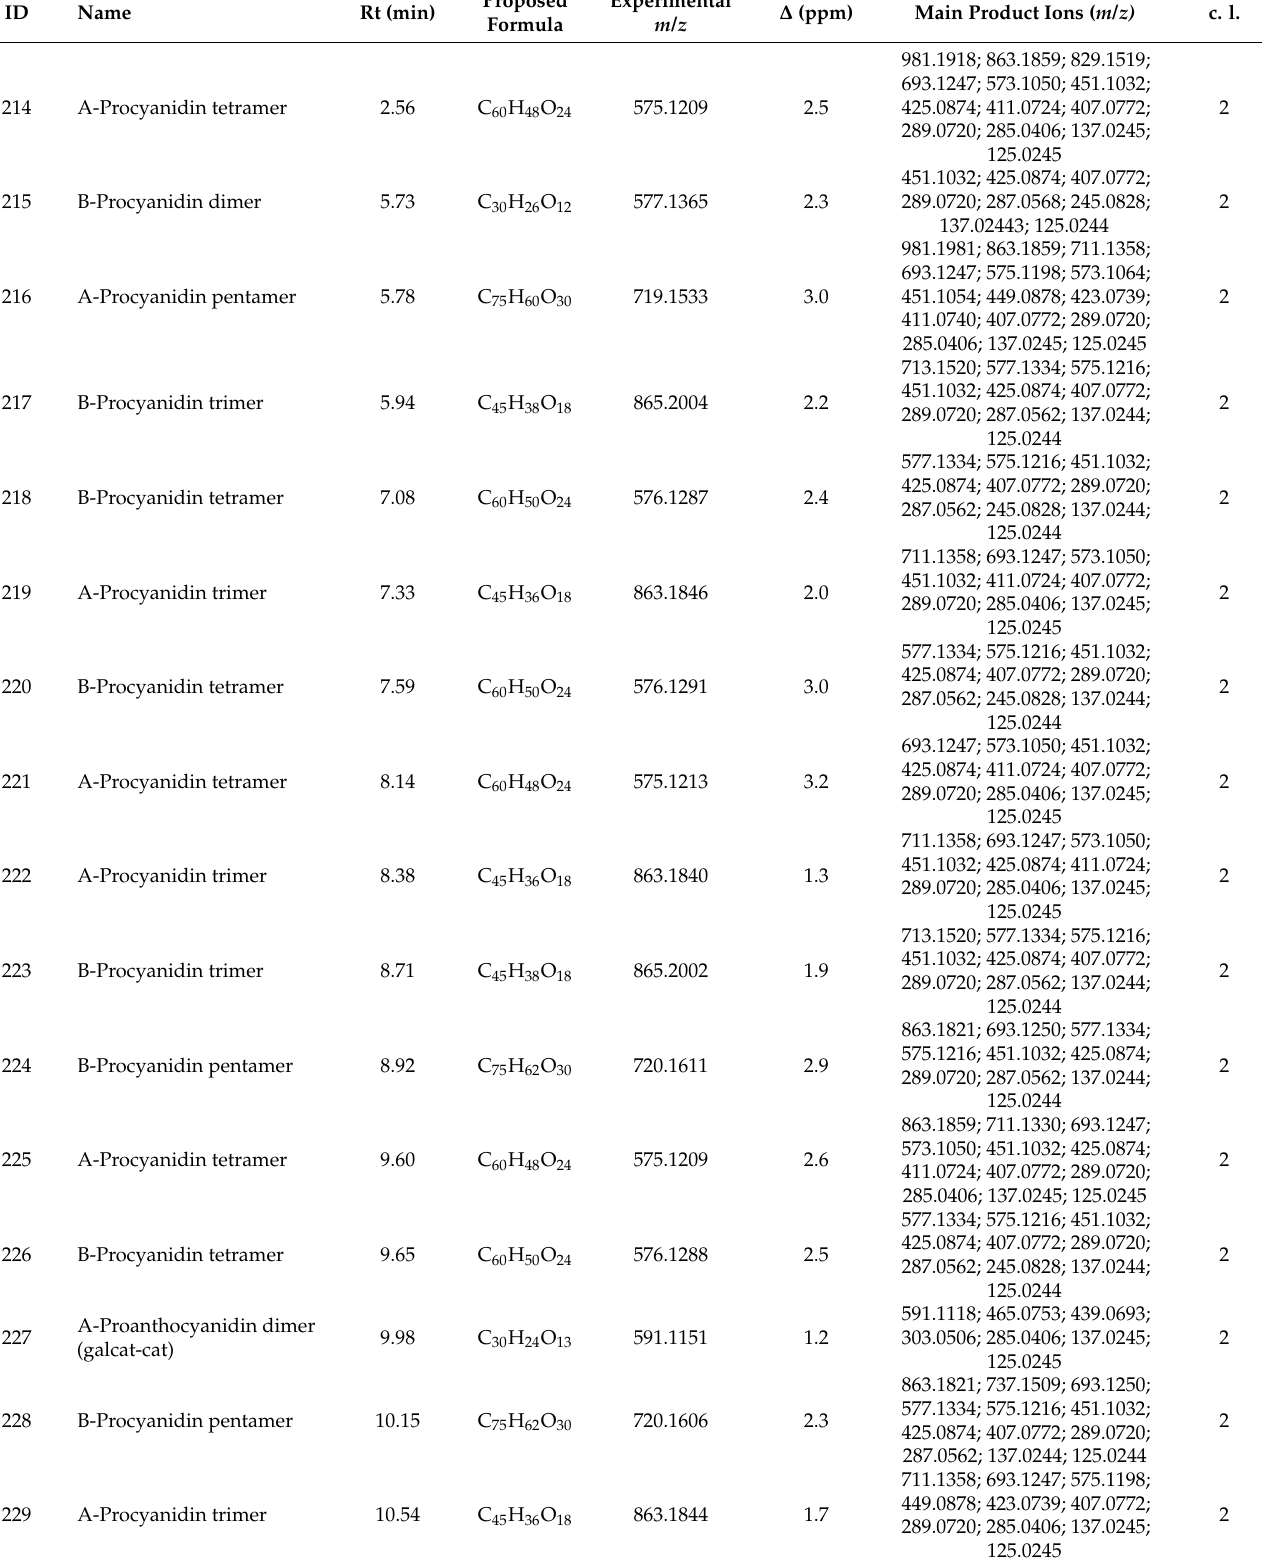
Table 4. Retention times (Rt, min), proposed formulas, experimental m/z , accuracy ( ∆ , ppm), main diagnostic experimental product ions, and confidence level of the identification (c. l.) of the 36 annotated proanthocyanidins in Disterigma alaternoides extract in